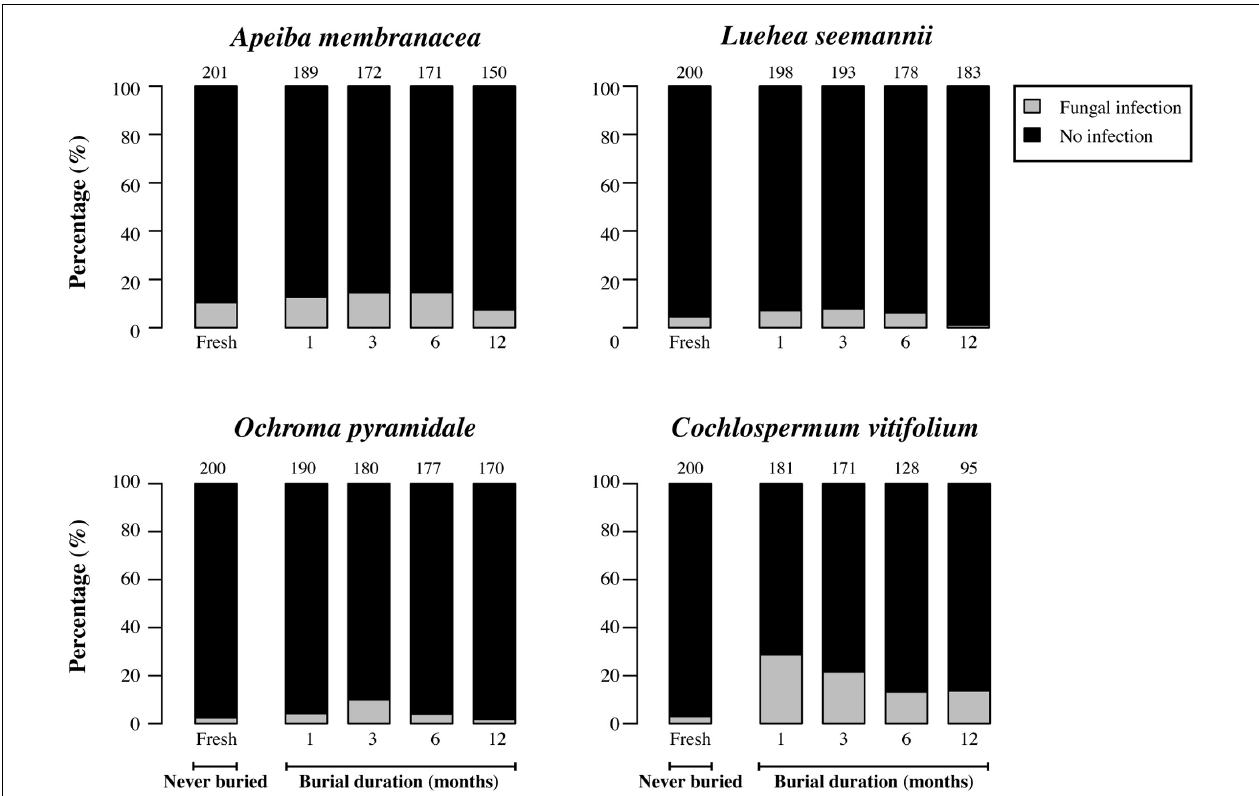
FIGURE 4 | Percentage of seeds infected by cultivable fungi (gray) and seeds without detectable infection (black) for fresh (unburied) seeds, and seeds successfully recovered at different time intervals following burial. Numbers at the top of each bar